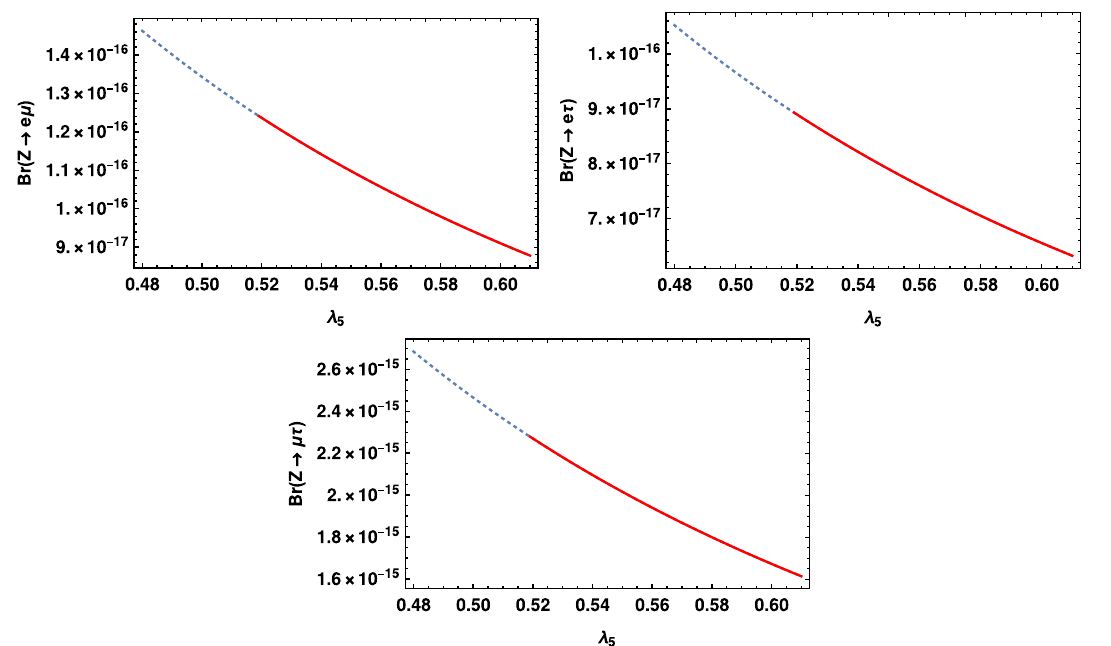
Fig. 5 Plots between Br ( Z → (cid:2) α (cid:2) β ) and λ 5 for the case of IO, after applying the constraints from Br ((cid:2) α → (cid:2) β γ) . In these plots, solid lines are allowed and dotted lines are excluded by the constraints due to Br ((cid:2) α → (cid:2) β γ) . Numerical values for neutrino masses are taken from